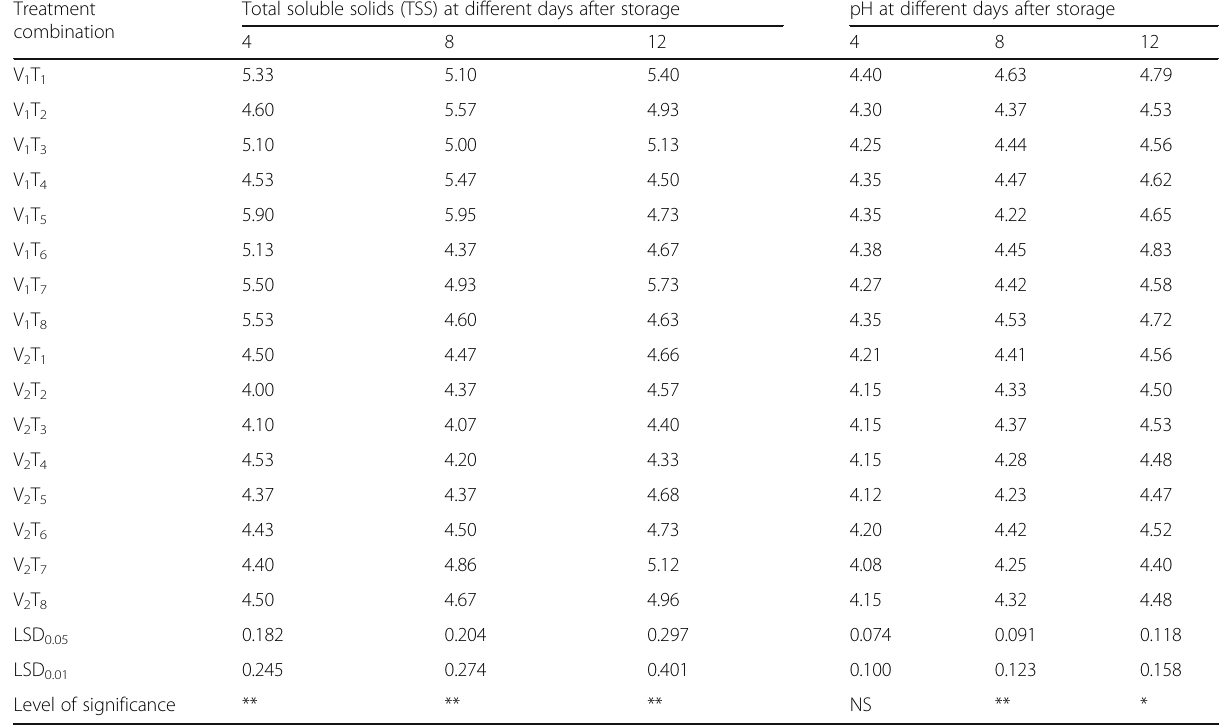
Table 8 Combined effects of varieties and postharvest treatments on total soluble solids of tomato during storage and ripening Treatment combination